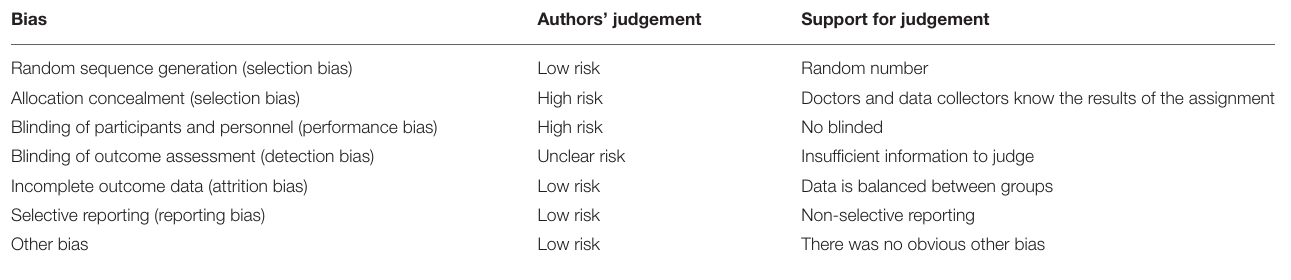
TABLE 3 | Risk of bias table.